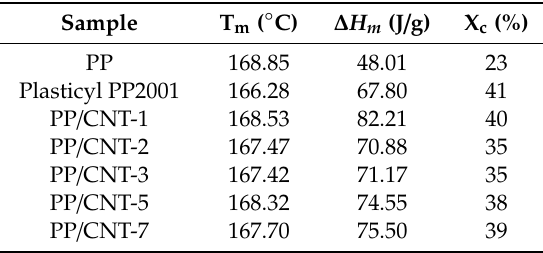
Plasticyl PP2001 and PP / CNT composites as determined during the second